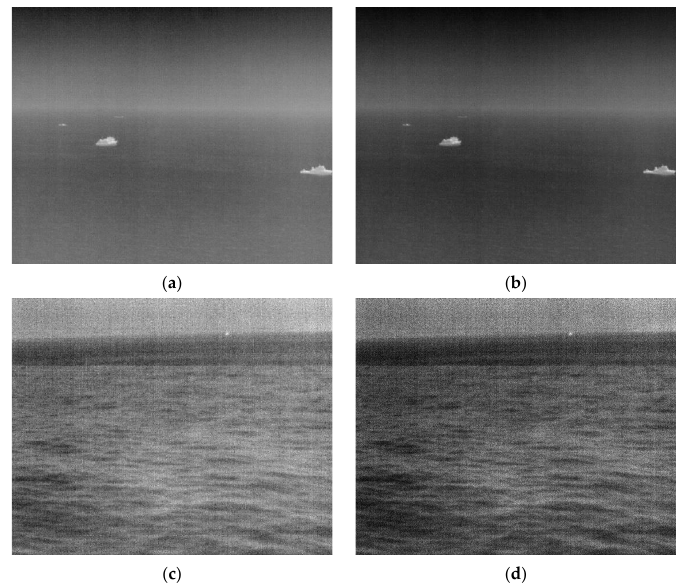
Figure 8. The original image and the result after contrast enhancement. ( a ) Original calm sea image containing two targets with complex contours and two dim targets; ( b ) the result image after the contrast enhancement of Figure 8a; ( c ) original rough sea image with a dim point target near the sea antenna; ( d ) the result image after the contrast enhancement of Figure 8c. According to the analysis results in Sections 2.1 and 2.2, it can be seen that the gra- dient of the sea surface area in the rough sea image is violent, and the texture infor- mation is richer. The more significant fluctuation of the waves, the more severe change of the gray value. Therefore, the fluctuation degree of the waves can be described by the standard deviation. The upper part of the image generally has part of the sky area, and the bottom part generally has only the sea surface area. To avoid the texture change of the target area affecting the measurement of sea surface roughness, the area of the bot- tom 50 rows of the image will be selected and divided into five juxtaposed partial blocks